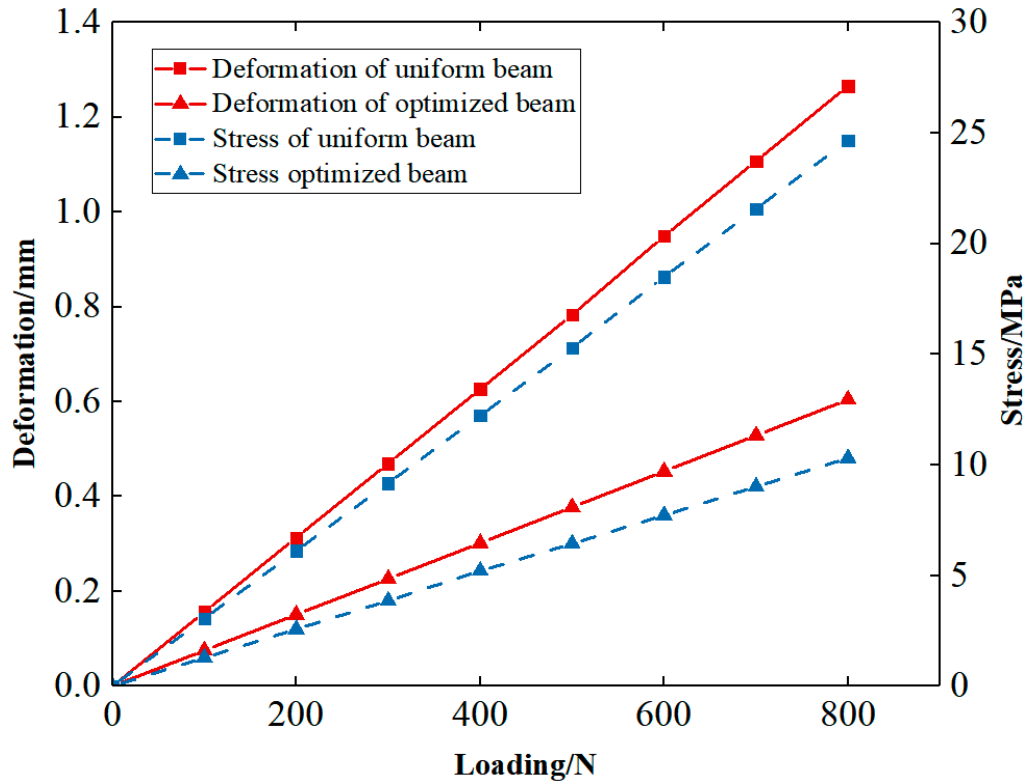
Figure 15. Comparison of maximum deformation and stress between uniform cellular structure and optimized FGCS.